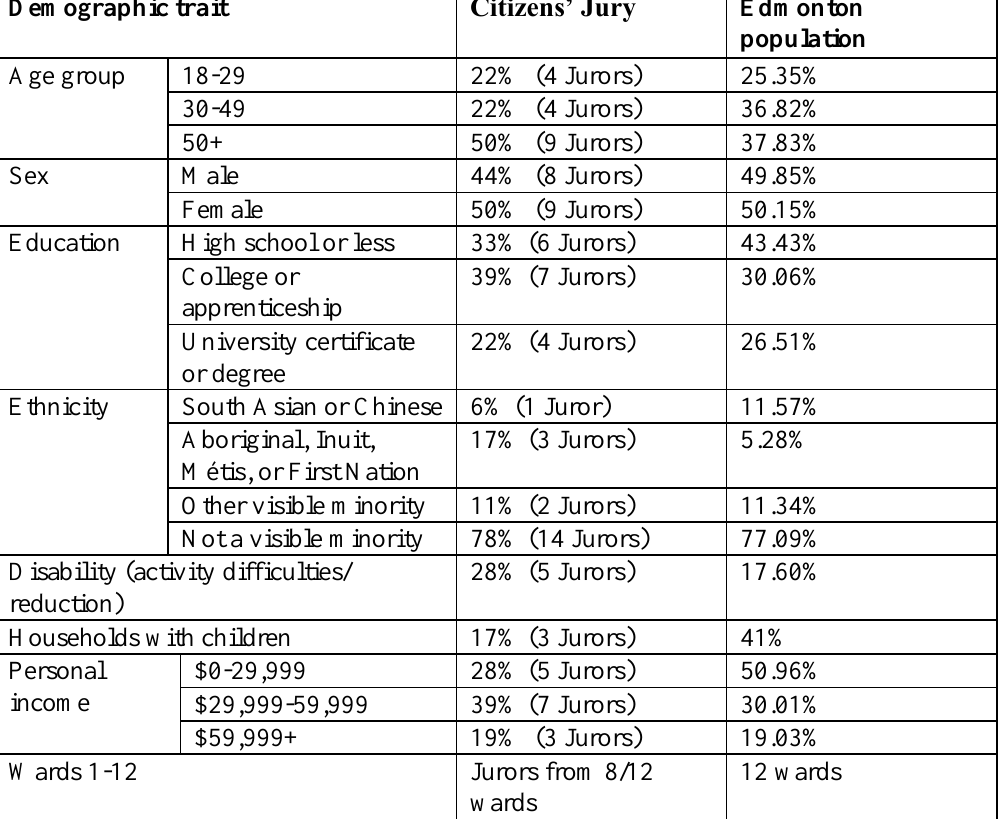
Table 3 Demographic characteristics of Jury members and the Edmonton population Demographic trait Citizens’